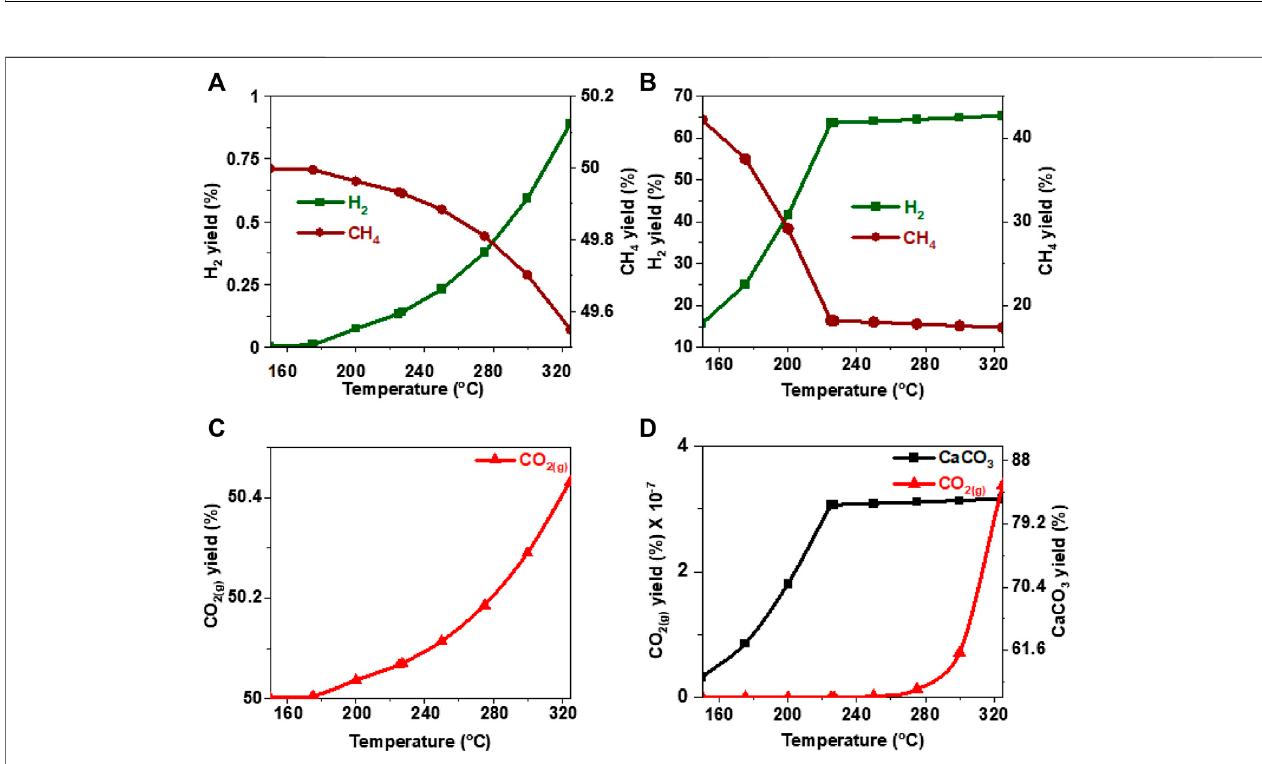
FIGURE 14 | Effect of temperature on the product yield from acetic acid (A , C) in the absence and (B) in the presence of calcium oxide. The yield of CO 2 post capture to produce calcium carbonate is represented in 13 (D) . These calculations are performed with temperatures of 227 ° C and pressures of 50 bar.